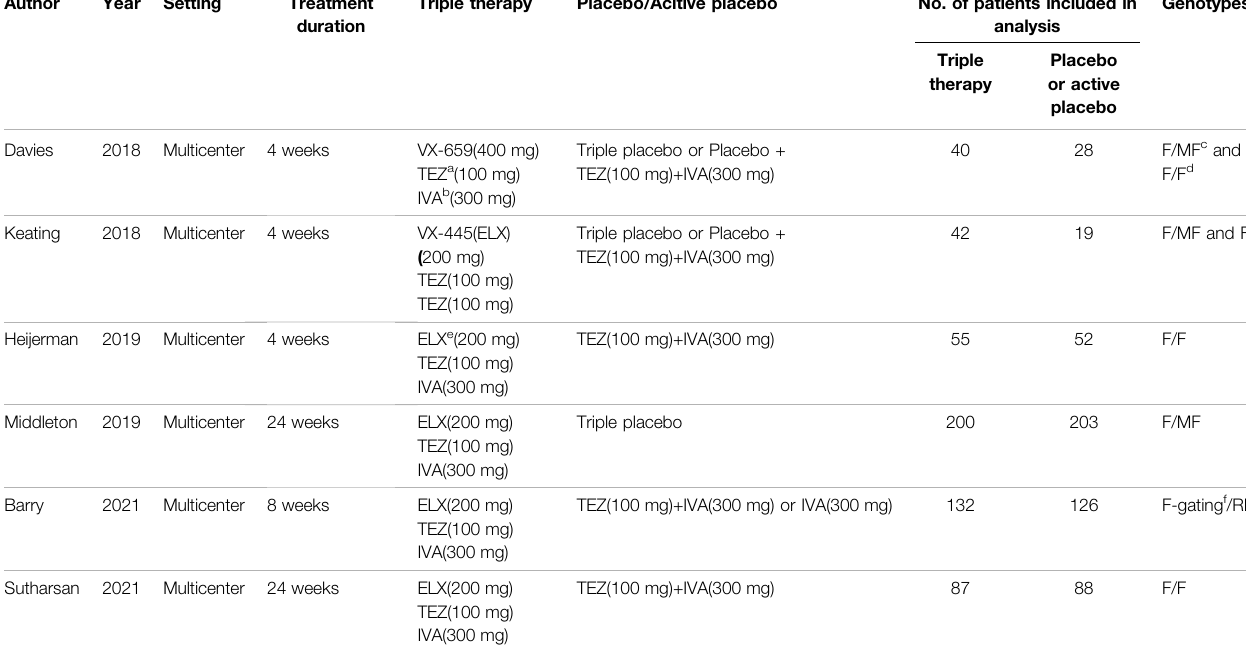
TABLE 1 | The main characteristics of included